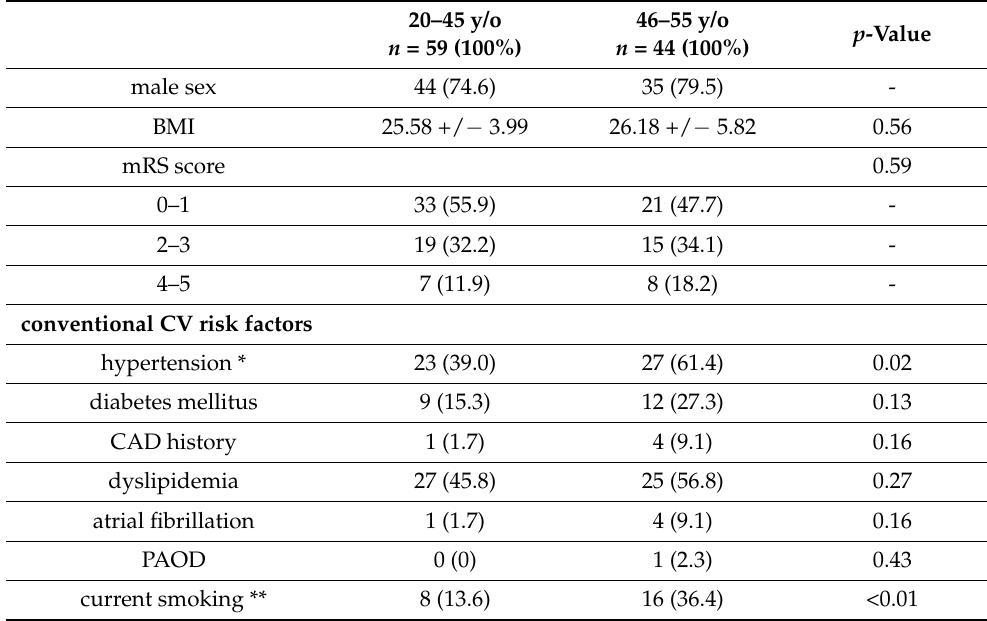
Table 1. The demographic characteristics and associated factors of all